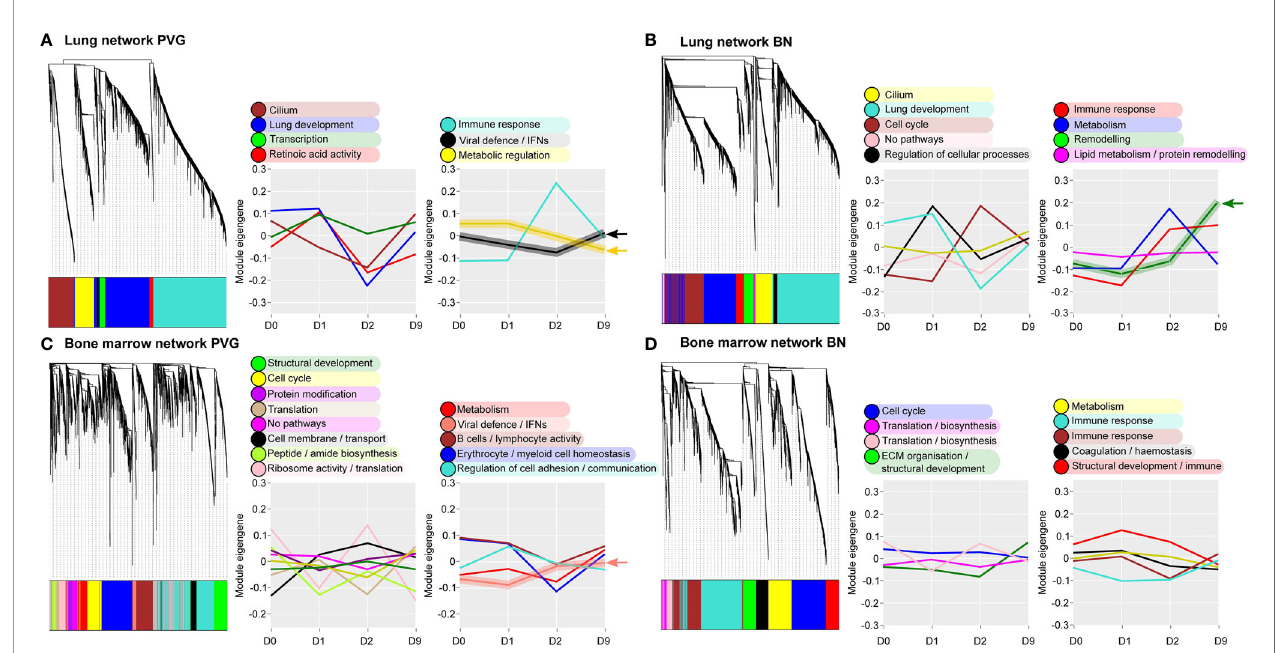
FIGURE 2 | Overview of the global gene networks operating in lung and bone marrow of PVG and BN rats. Separate tissue-speci fi c weighted co-expression gene networks were generated for PVG and BN lung (A, B) and bone marrow (C, D) . Dendrograms are shown for each network, where distinct color blocks represent separate functional modules (clusters of correlated or co-expressed genes). Associated module functions are described for each network and the summarized expression of each module (eigengene value) is shown over the course of viral infection and allergen challenge. Modules relating to immune and metabolic pathways are separated (right) from all others (left). Arrows highlight four modules speci fi c to PVG or BN rats. Sample sizes for network construction: BN bone marrow n = 47, PVG bone marrow n = 49, BN lung n = 48, PVG lung n =